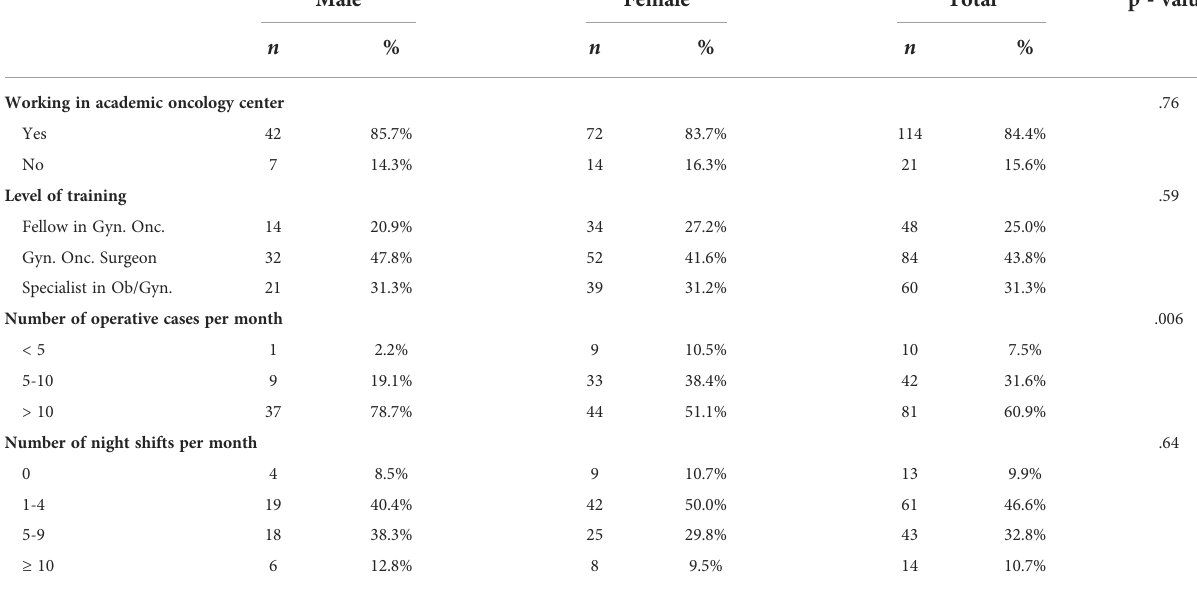
TABLE 2 Clinical characteristics.